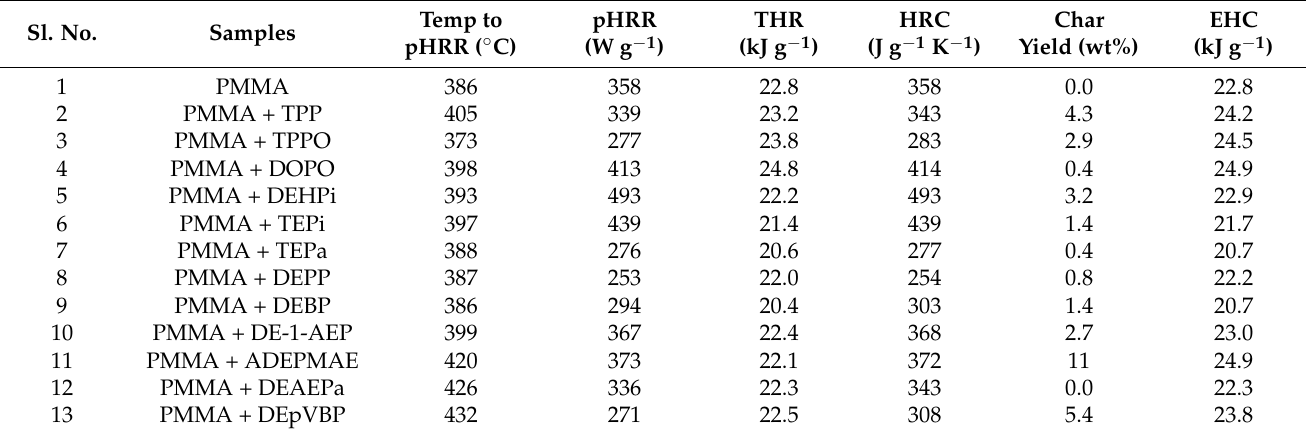
Table 6. PCFC data of PMMA-based materials.